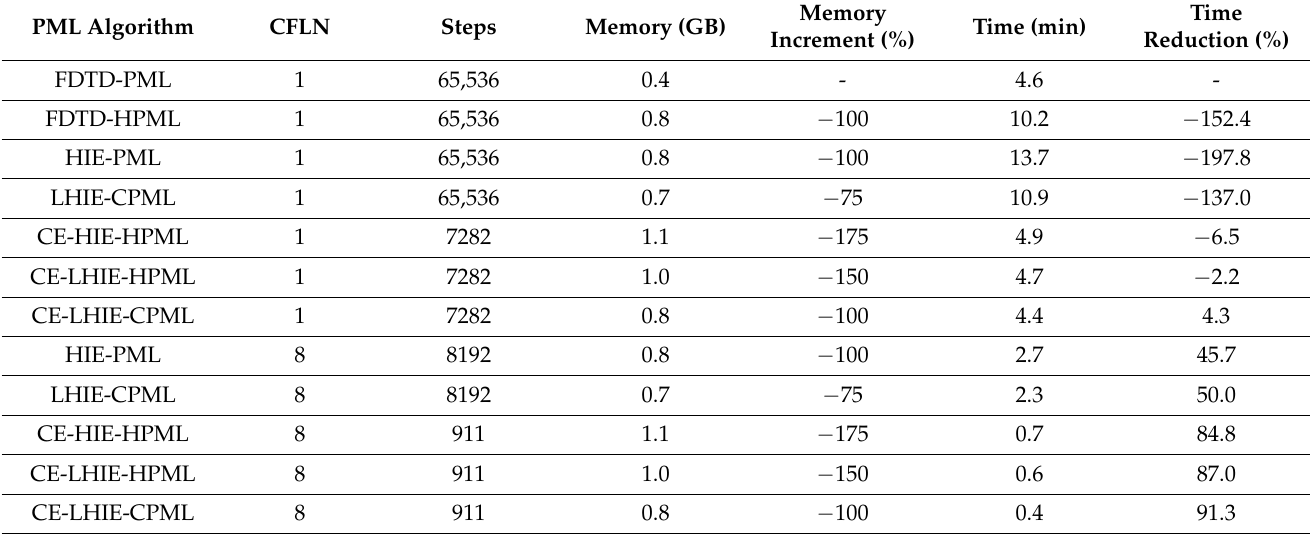
Table 4. The computational duration, consumption memory, iteration step, memory increment and time reduction obtained by different PML algorithms in the sphere